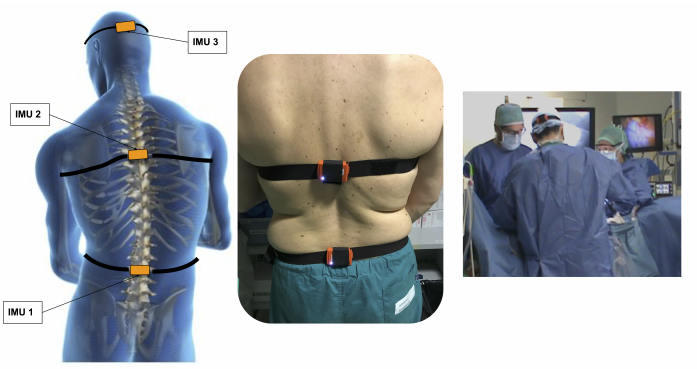
Figure 3. Representation of sensor placement, final application on the surgeon’s body, and an image of the Operating Room during the platform